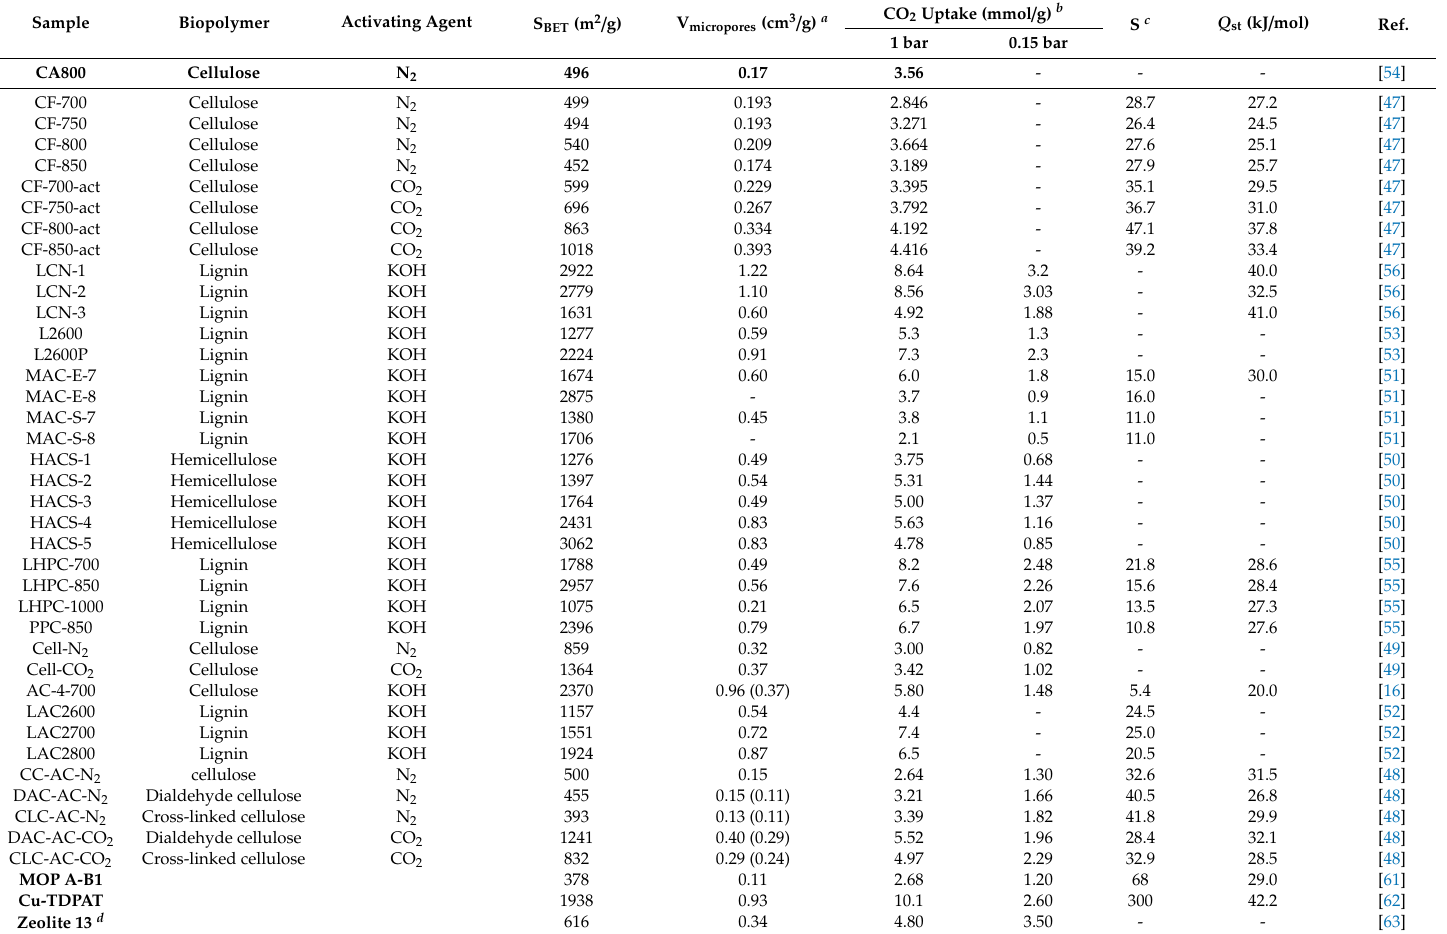
Table 1. A summary of biopolymer-based porous carbons and their textural properties, CO 2 uptake, CO 2 / N 2 selectivity and heat of adsorption. Other selected sorbents (porous polymer, metal-organic frameworks (MOF), zeolite) are also included for